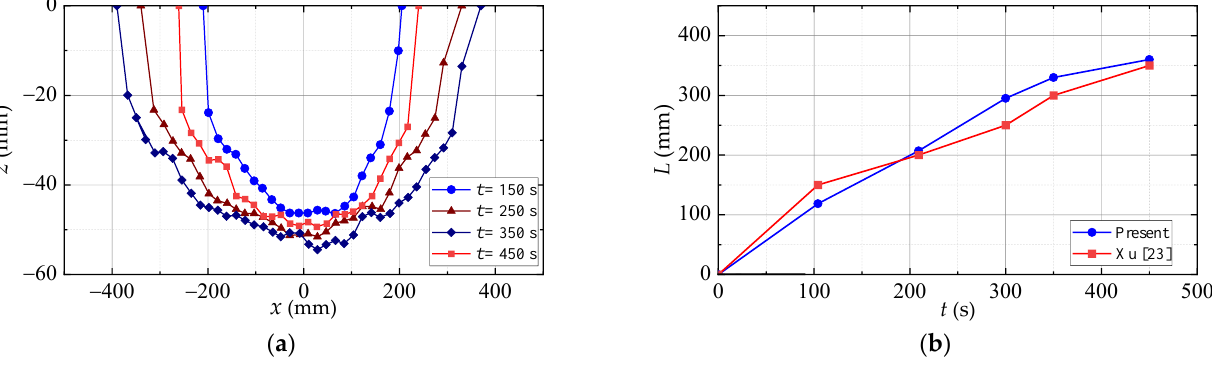
Table 3. 3D-single pipeline scour model parameters.